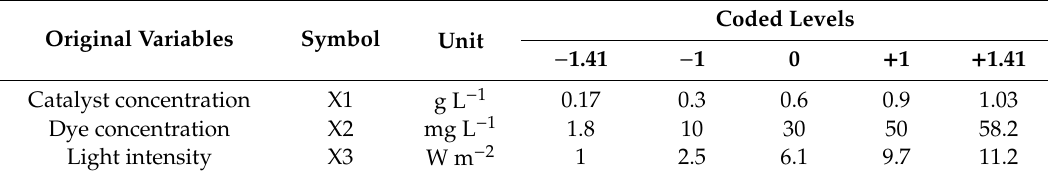
Table 3. The original and coded levels of the input